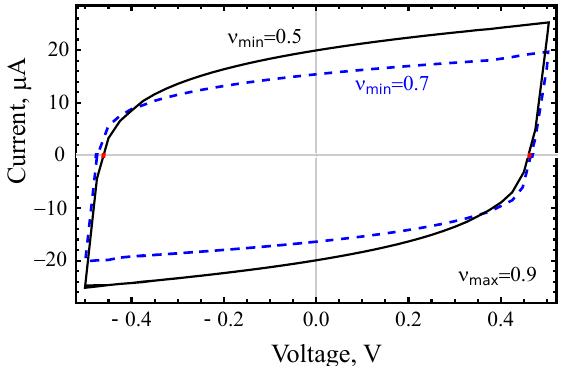
Figure 9. Theoretical charging-discharging curves ( a ) and cyclic voltammograms ( b ) predicted by the distributed-order fractional model.